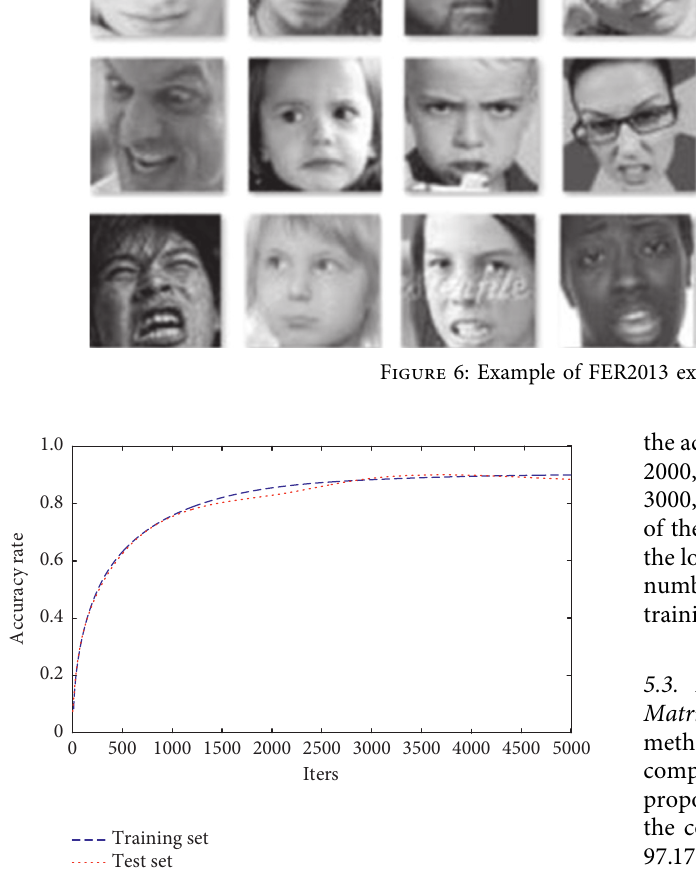
Figure 7: Experimental accuracy change diagram of facial ex- pression recognition based on improved AlexNet network.